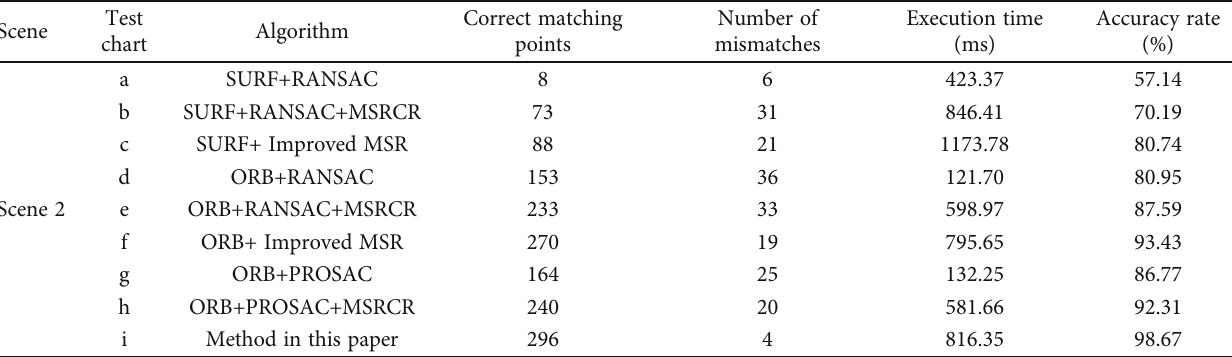
Table 2: Performance comparison of various algorithms in the global scene of experiment 2.